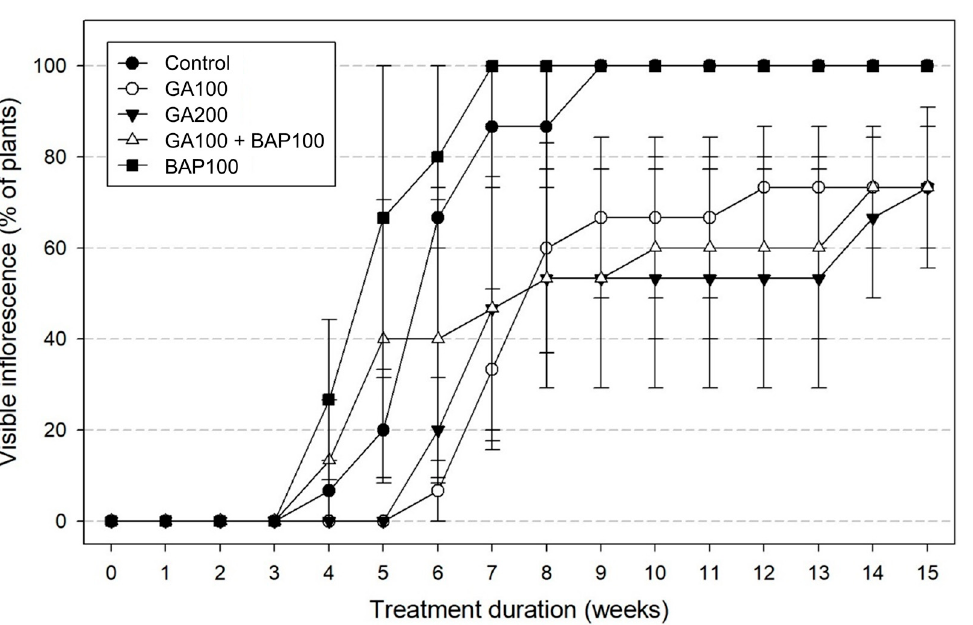
Figure 3. Percent of Phalaenopsis Queen Beer ‘Mantefon’ plants with visible inflorescence treated with exogenous gibberellic acid 3 (GA 3 ) and 6-benzylaminopurine (BAP) at 20 °C forcing temperature. Control: no hormones; GA100: GA 3 100 mg/L; GA200: GA 3 200 mg/L; GA100 + BAP100: GA 3 100 mg/L + BAP 100 mg/L; BAP100: BAP 100 mg/L.